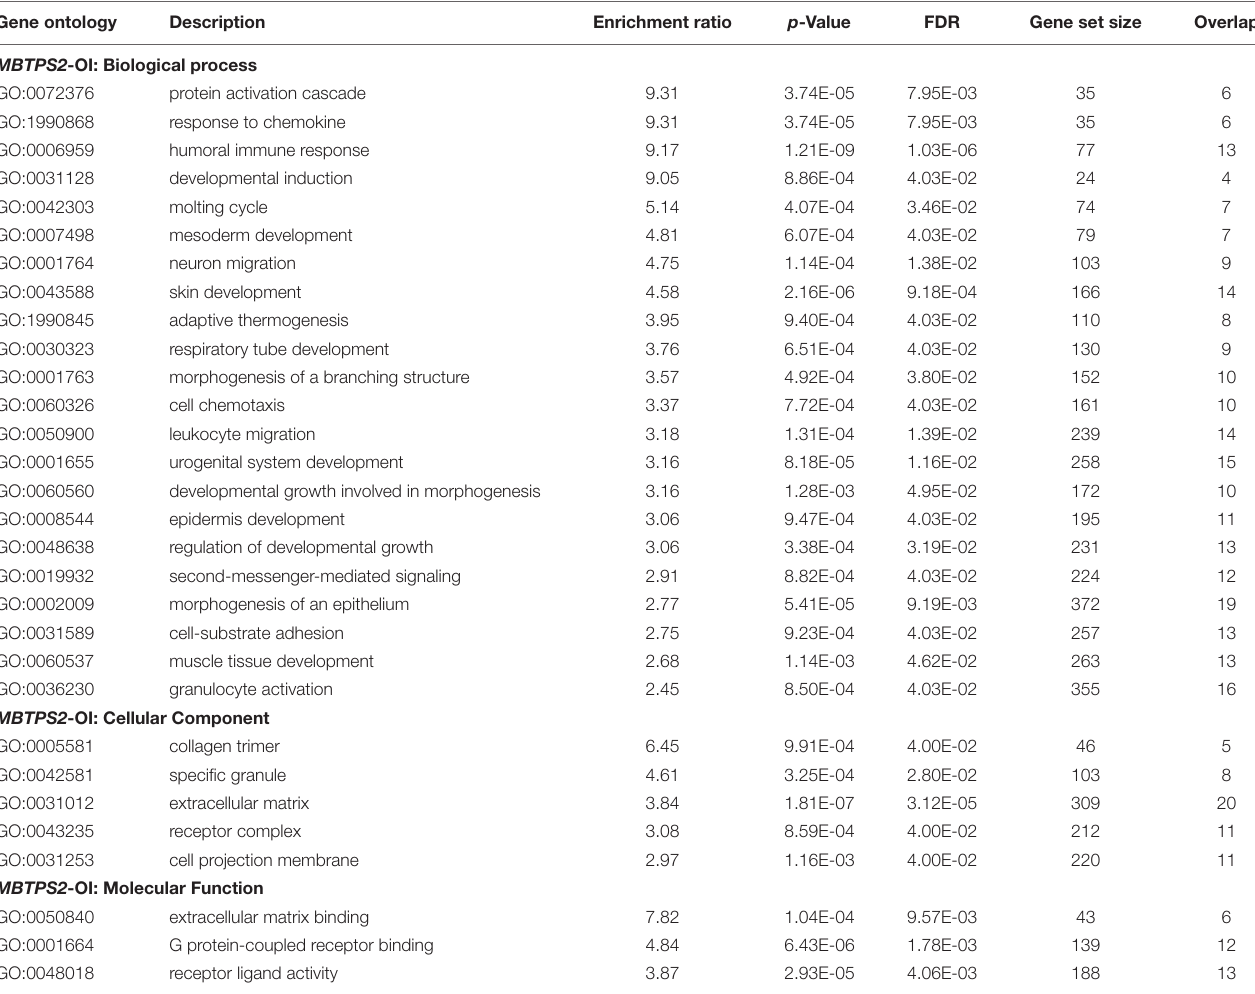
TABLE 1 | Over-represented GO terms amongst the DEGs in MBTPS2 -OI vs. controls. Gene ontology Description Enrichment ratio p -Value FDR